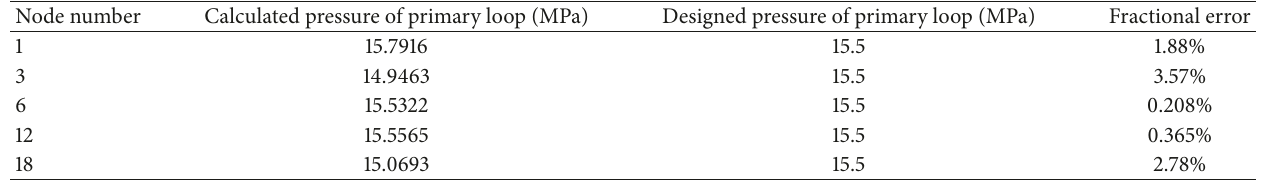
Table 9: The influence of pressurizer node number on the primary loop pressure.